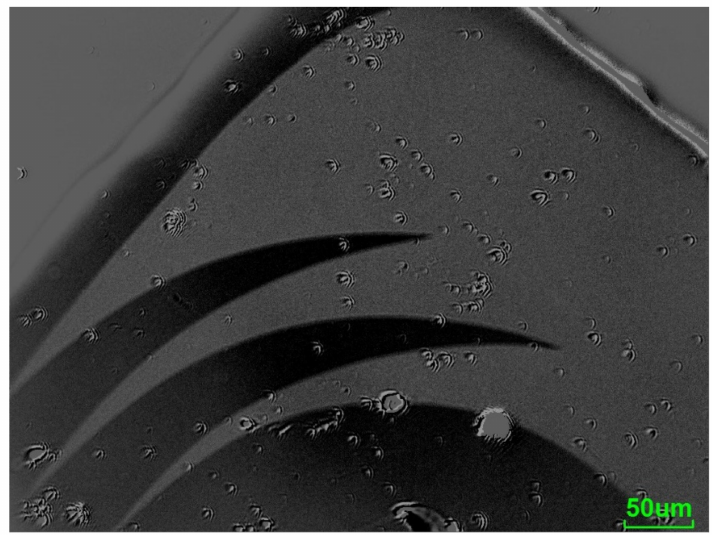
Figure 11. MOKE image with the sensitivity in plane at one corner of the sample with a residual stress of around − 400 MPa.